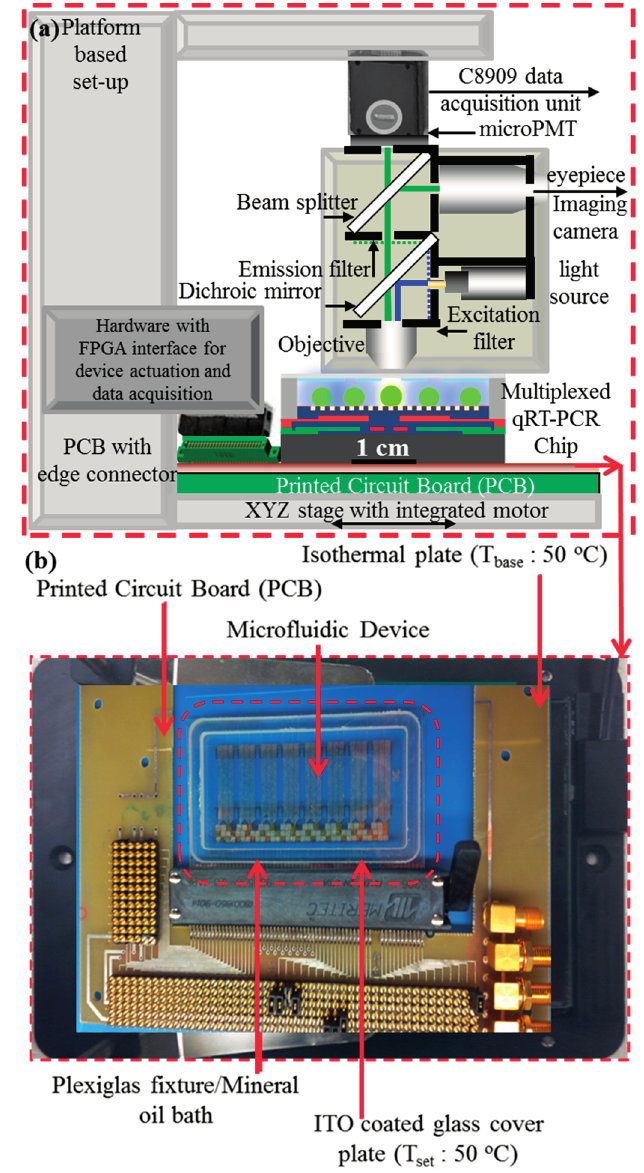
Figure 2. ( a ) Schematic diagram of the experimental setup; ( b ) An image of the microchip-PCB (Printed Circuit Board)